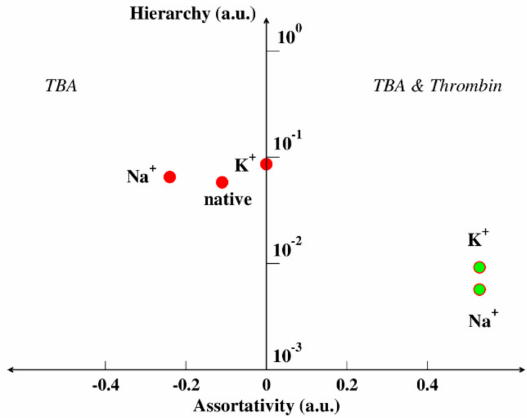
Figure 7. Hierarchy-assortativity plot of the aptamer TBA. On the left, the aptamer alone, in the native state or in the configuration it assumes when bound to the receptor, in the presence of two different cations. On the right, the couple TBA-thrombin, in the presence of both